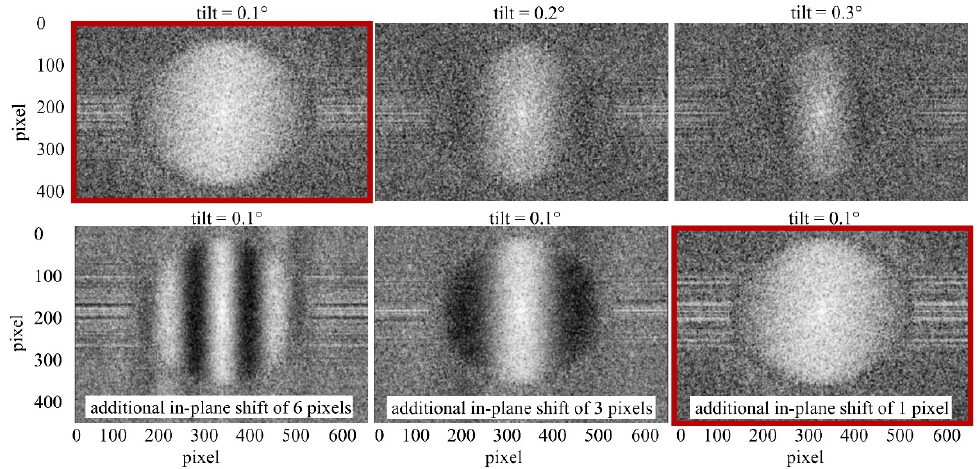
Figure 3. Power spectra of two speckle patterns for tilted or additional displaced measurement sur- faces.